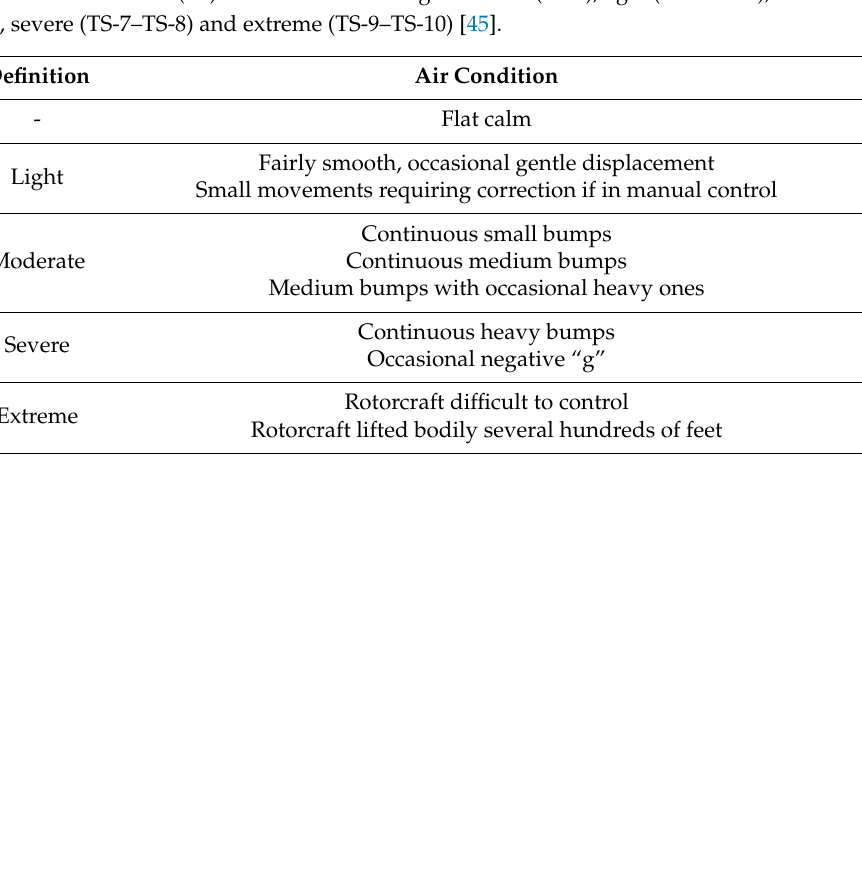
Table A2. Turbulent Air Scale (TS) with turbulence categories none (TS-1), light (TS-2–TS-3),